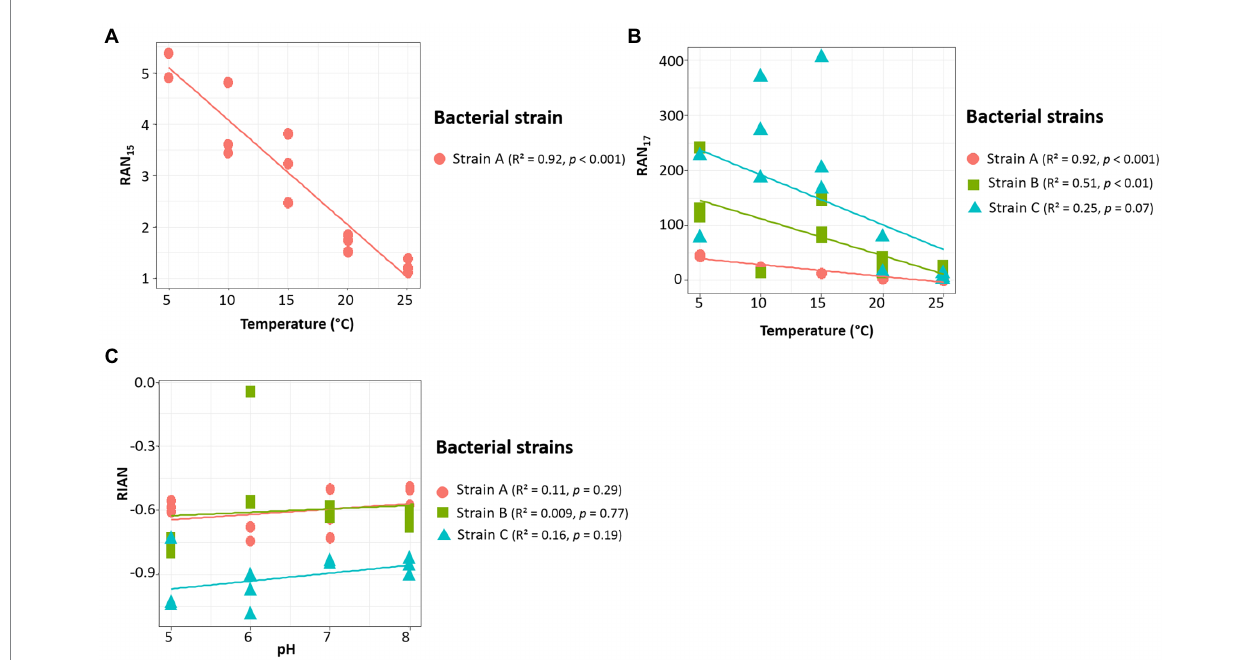
FIGURE 3 Relationships between temperature and RAN 15 (A) and RAN 17 (B) and between pH and RIAN (C) parameters ( cf. 2.4 section for the equations of the indices) for the three Gram-negative bacterial strains isolated from soils of the French Alps. Strain A: Flavobacterium pectinovorum (98.78% similarity). Strain B: Pedobacter lusitanus NL19 (98.54% similarity). Strain C: Pedobacter panaciterrae (99.27% similarity). Each point corresponds to one